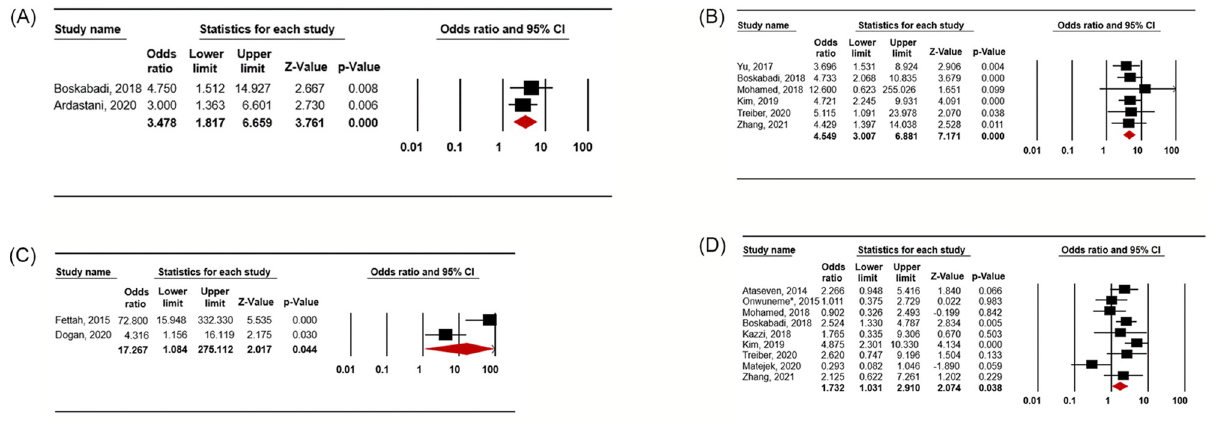
Fig 2. Meta-analysis for the association between vitamin D deficiency and respiratory distress syndrome according to the definition of vitamin D deficiency. (A) Vitamin D deficiency < 30 ng/ml, (B) Vitamin D deficiency < 20 ng/ml, (C) Vitamin D deficiency < 15 ng/ml, (D) Vitamin D deficiency < 10